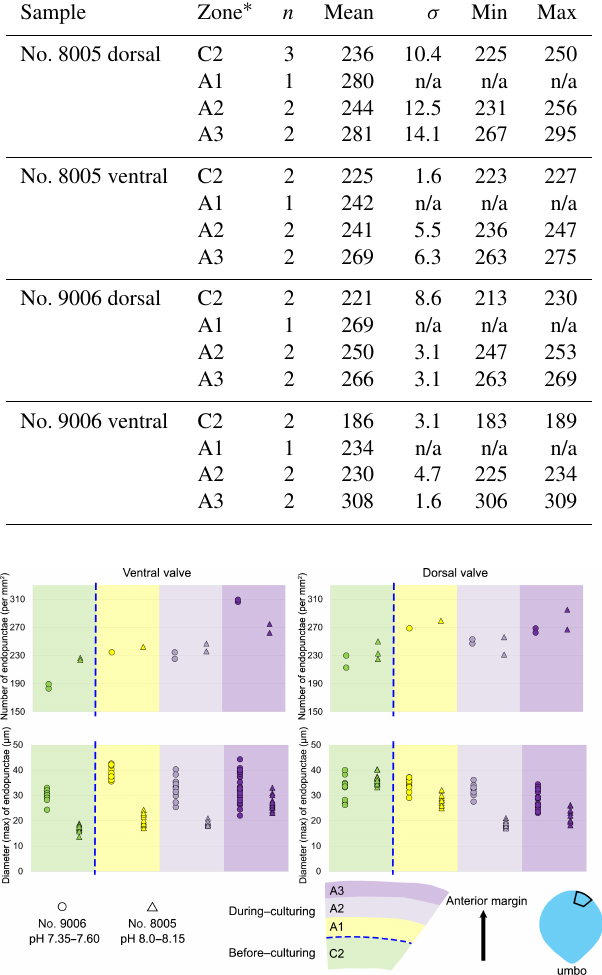
Figure 7. Variation in the number and diameter (max) of endopunc- tae in the dorsal and ventral valves from a specimen of M. venosa cultured at pH 7.35 and 7.6 (no. 9006) and a specimen cultured at pH 8.0 and 8.15 (no. 8005).